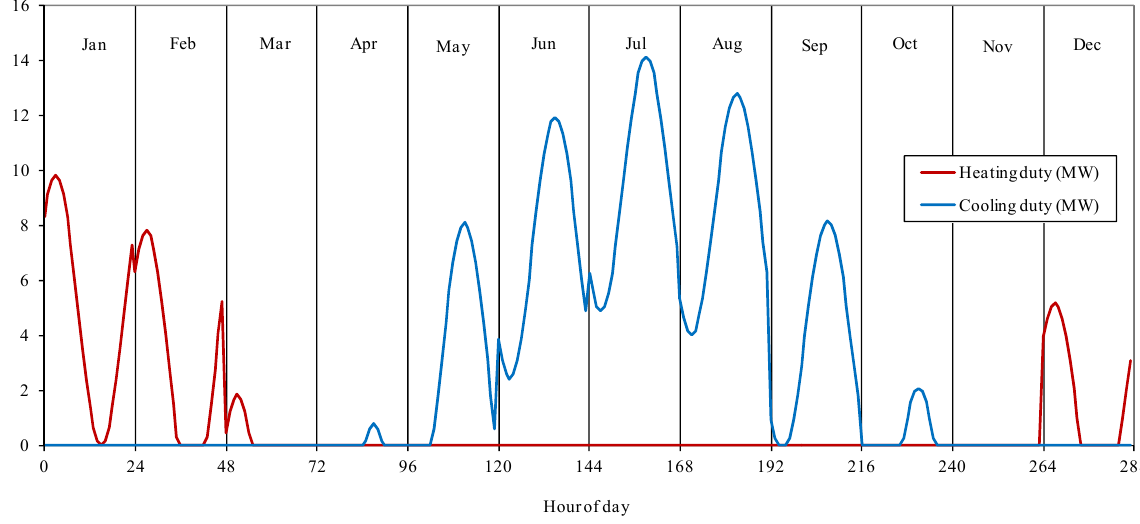
Figure 5. Heating and cooling demand profile projections for a 2500 m deep mine located in Canada at latitude 46°